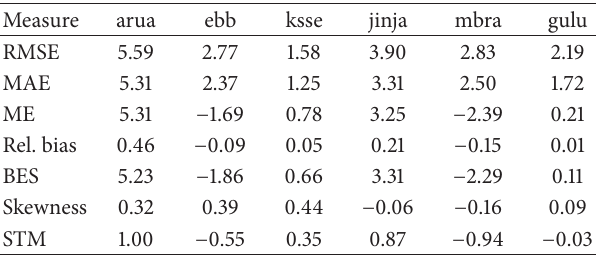
Table 2: Statistical bias measures of actual and model simulation for minimum